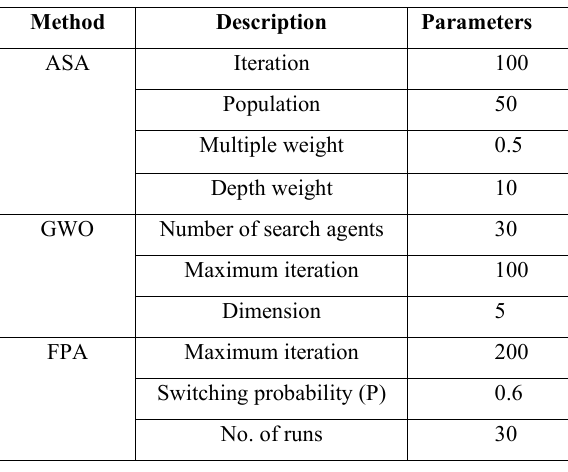
Table 1. Implementation parameters of proposed and existing